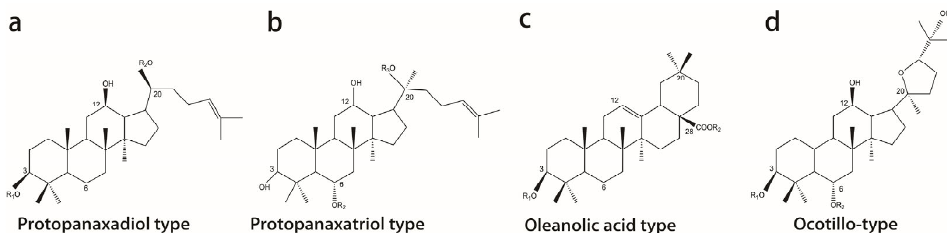
Figure 1. Chemical structures of ginsenosides. ( a ) Protopanaxadiol type; ( b ) protopanaxatriol type; ( c ) oleanolic acid type; and ( d ) ocotillo type.